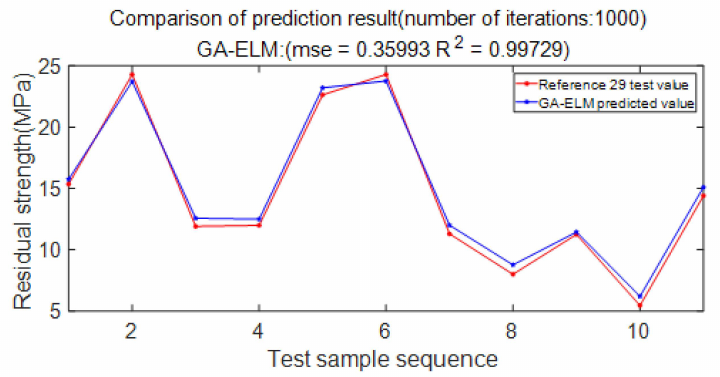
Figure 18. Comparison of forecast